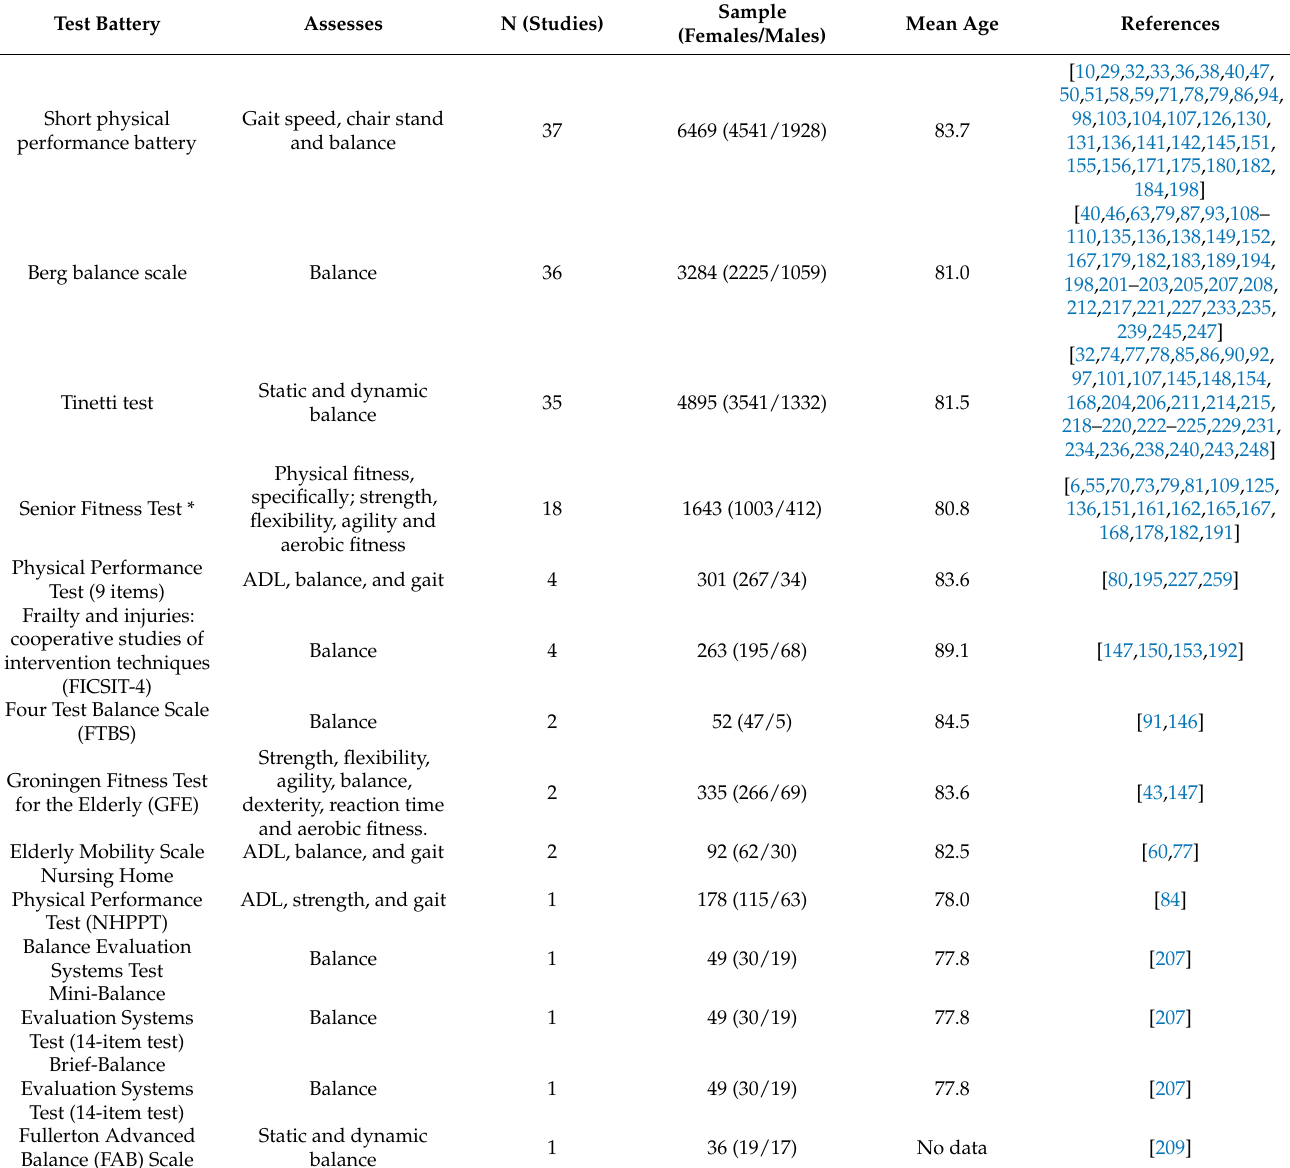
Table 2. Batteries of physical and motor tests applied in the reviewed